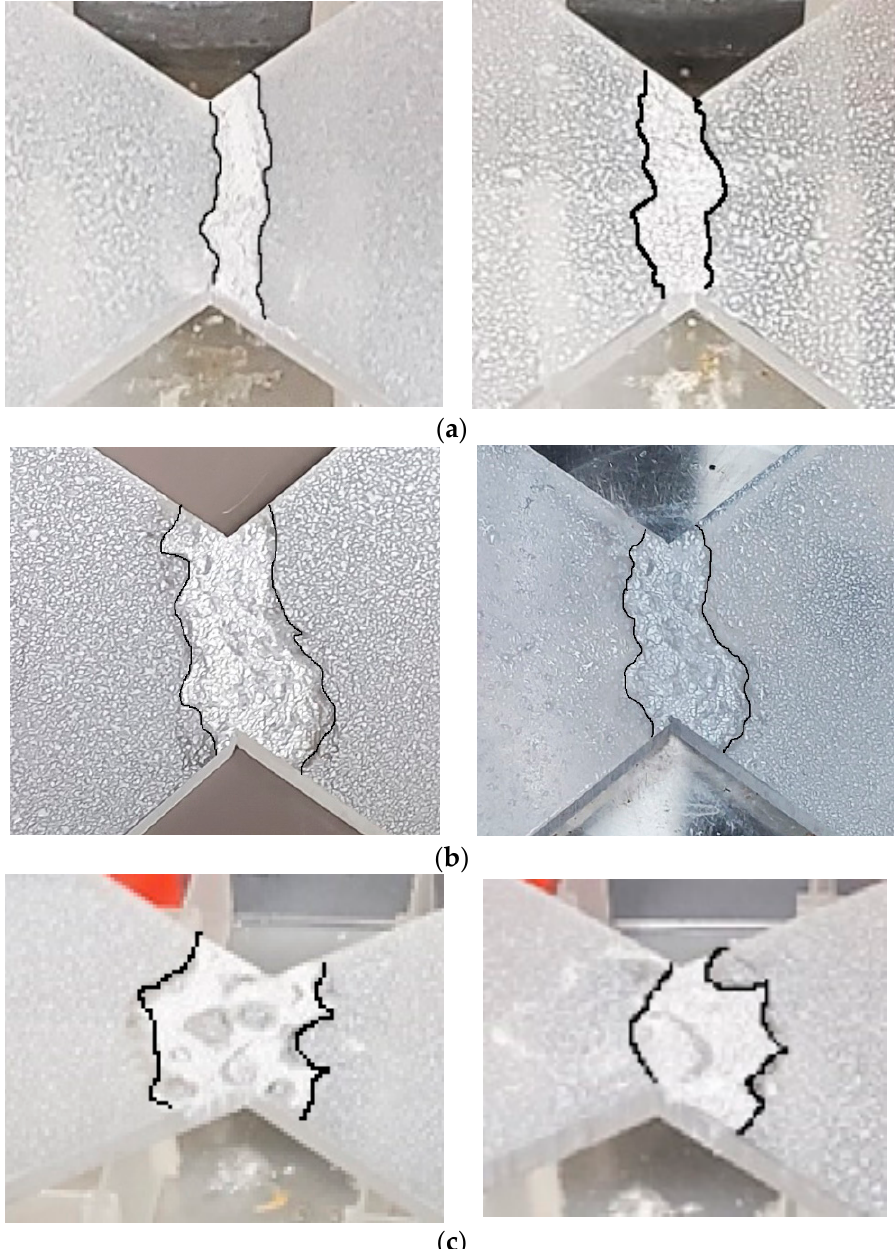
Figure 13. Examples of dry band formation obtained on the Plexiglass sample for an average ESDD of 1.34 mg/cm 2 for applied voltages of ( a ) 2 kV, ( b ) 4 kV and ( c ) 6 kV.